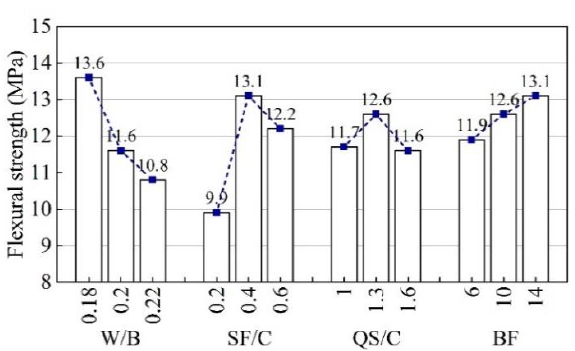
Figure 6. Flexural strength of the BFRPC.